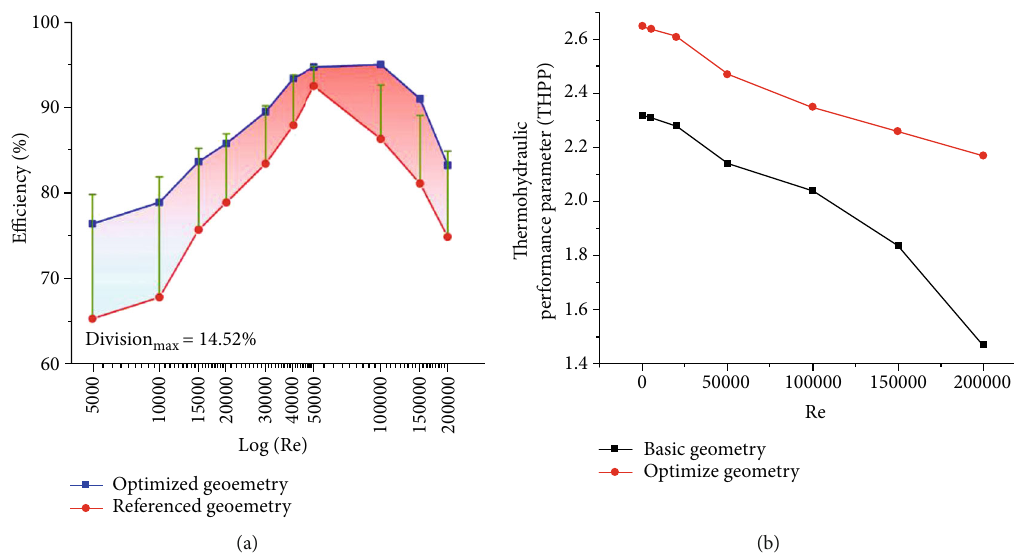
Figure 7: Illustration of energy e ffi ciency and thermohydraulic performance parameters for reference and optimized geometries: (a) energy e ffi ciency comparison for di ff erent Reynolds numbers and (b) thermohydraulic performance parameters for SAHs for di ff erent Reynolds numbers